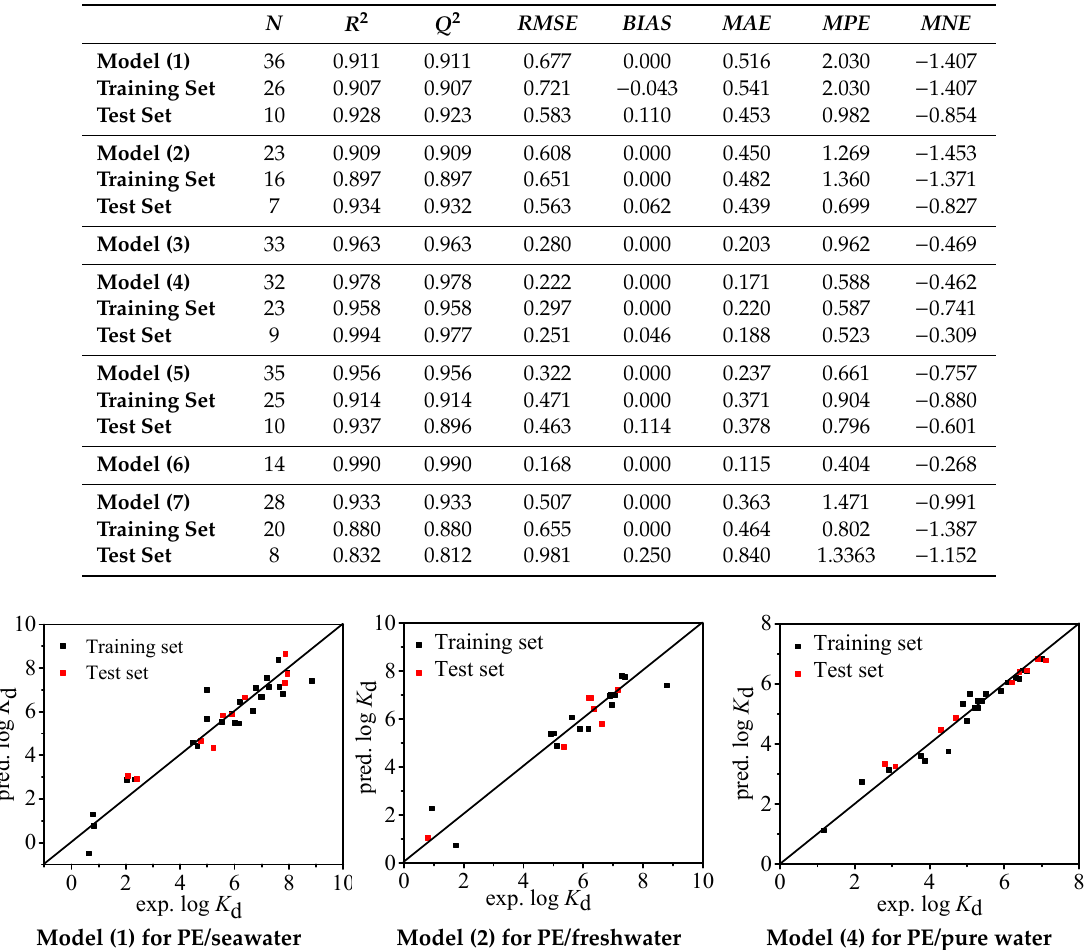
Table 1. Statistical parameters of the regression models and simulated external validation.